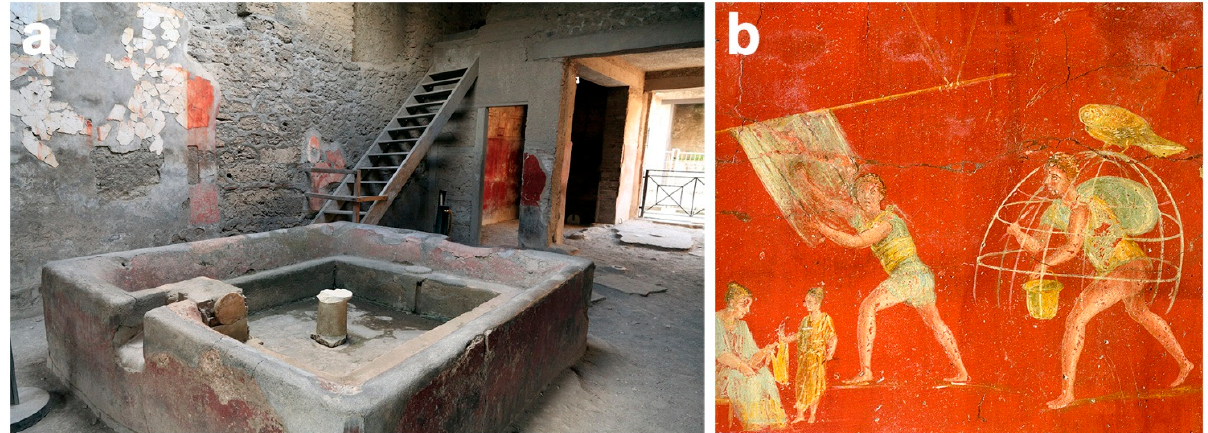
Figure 5. ( a ) Fullonica of Stephanus ( Pompeii ), showing the atrium with laundry basin [Author: WolfgangRieger. Distributed under a CC BY-SA 4.0 license. Available